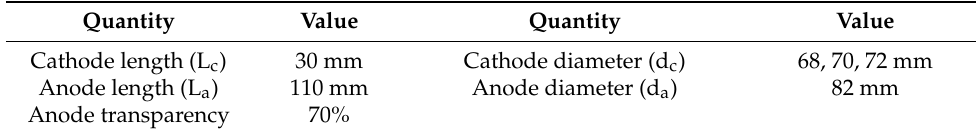
Figure 4. Inner structure of the coaxial vircator. Table 3. Design parameters of the proposed coaxial vircator diode.